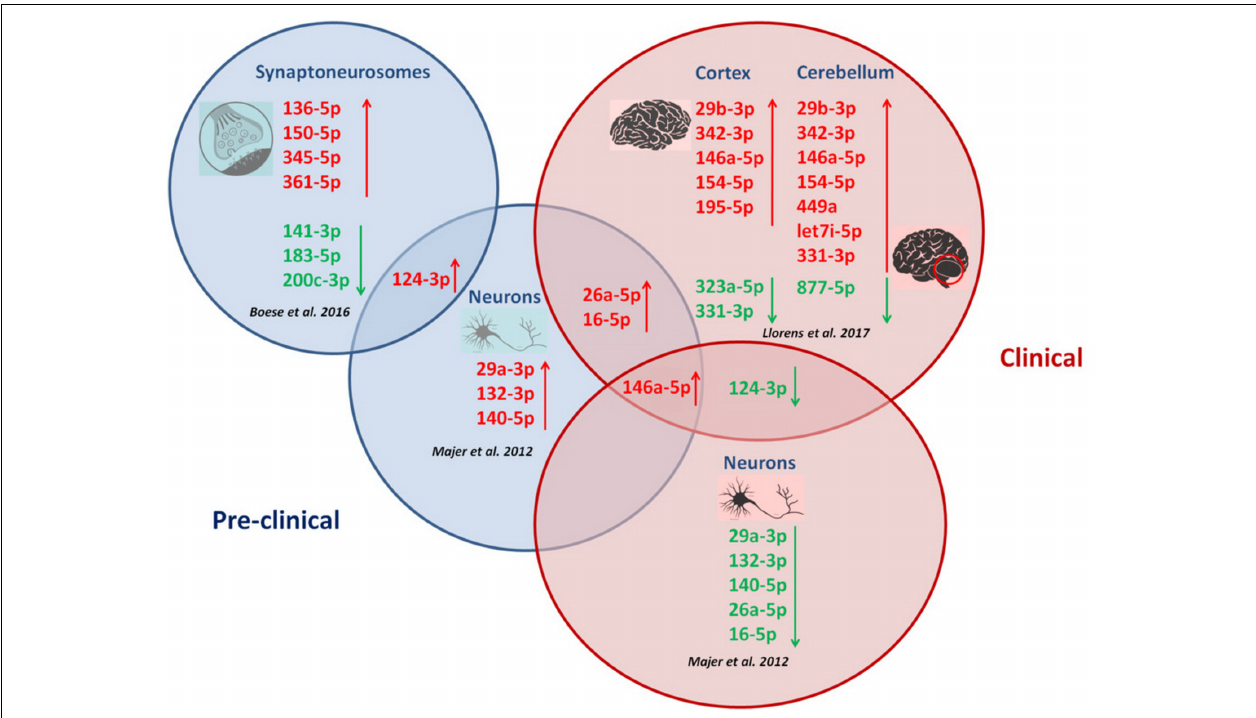
FIGURE 1 | Correlation between miRNA alterations and disease progression in prion diseases. Temporal miRNA profilng during prion disease progression in CA1 neurons (Majer et al., 2012), synaptoneurosomes (Boese et al., 2016) and brain regions (Llorens et al., 2017) revealed distinct miRNA alterations with disease progression. Different disease stages are featured by specific miRNA signatures. Upregulation of miR-146a-5p, miR-16-5p and miR-26a-5p appeared in two prion disease models across disease progression. Downregulation of miR-124-3p was specifically observed during clinical prion disease stages, while the same miRNA (miR-124-3p) was found upregulated in CA1 neurons and synaptoneurosomes at pre-clinical stages in two prion disease